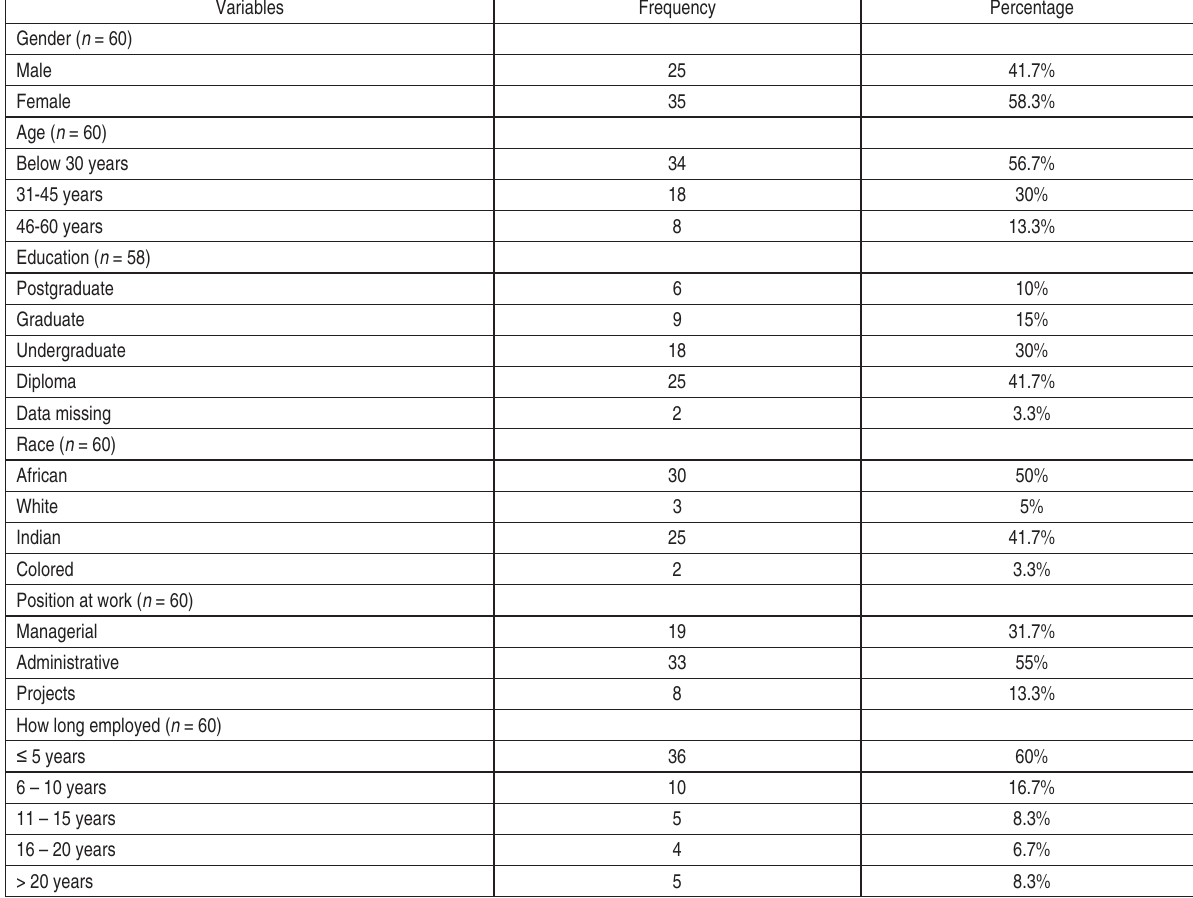
Table 1. Socio-demographic information of